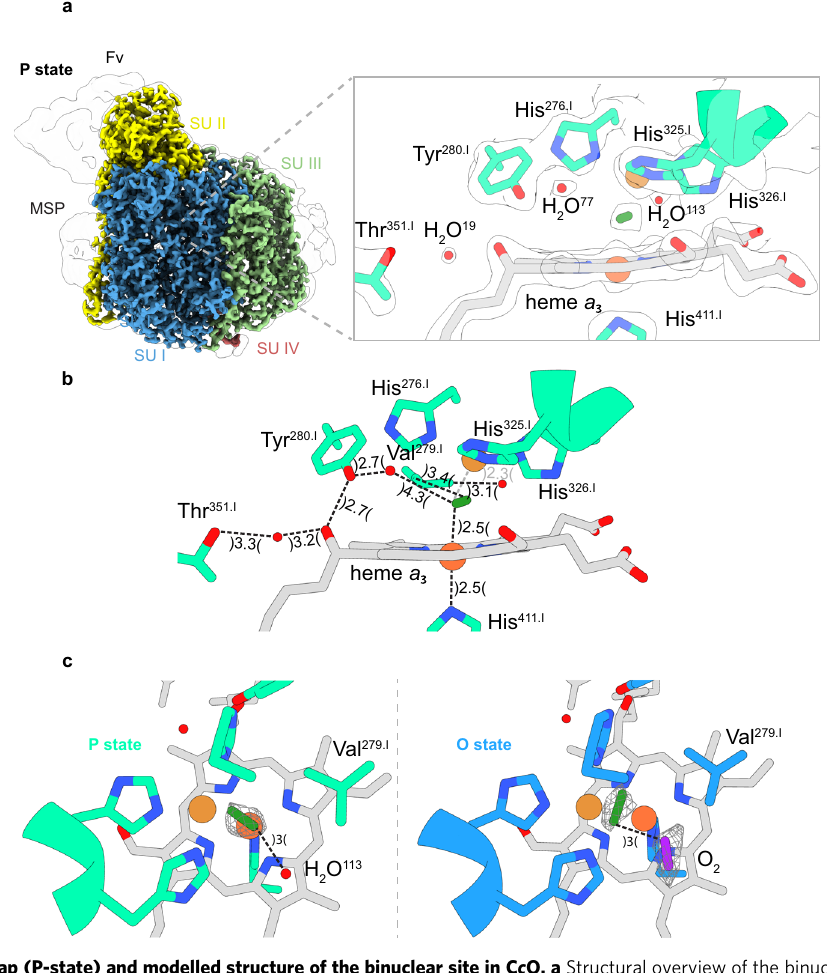
Fig. 7 Cryo-EM density map (P-state) and modelled structure of the binuclear site in C c O. a Structural overview of the binuclear site in the P -state. The bridging dioxide ligand (green) is embedded between the iron (orange) and the copper (brown) atom. The previously observed dioxygen molecule in the O -state near Val 279.I is replaced by a water (H 2 O 113 ). b Measured distances (Å) for the modelled molecules at the active site. c Top view of the binuclear center of the O and P -state to illustrate the rotation of the bridging dioxide species. The corresponding density map is illustrated as a white surface or mesh volumes. Illustrated map densities are fi ltered to equal contour levels of